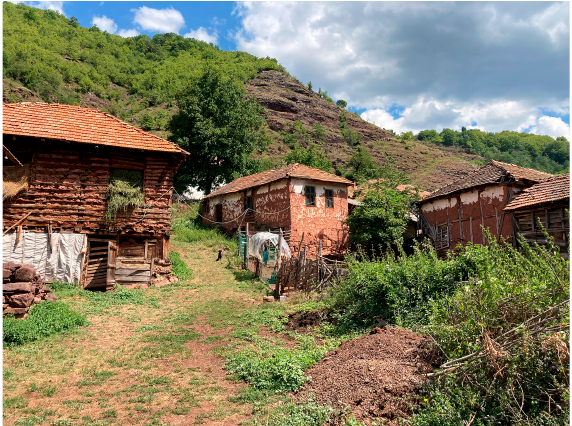
Figure 1. Dojkinci village on Stara planina in Pirot district. Photo: M. Stanimirovic, 2022. Rural architecture is one of the main elements for a tt racting tourism in this area.